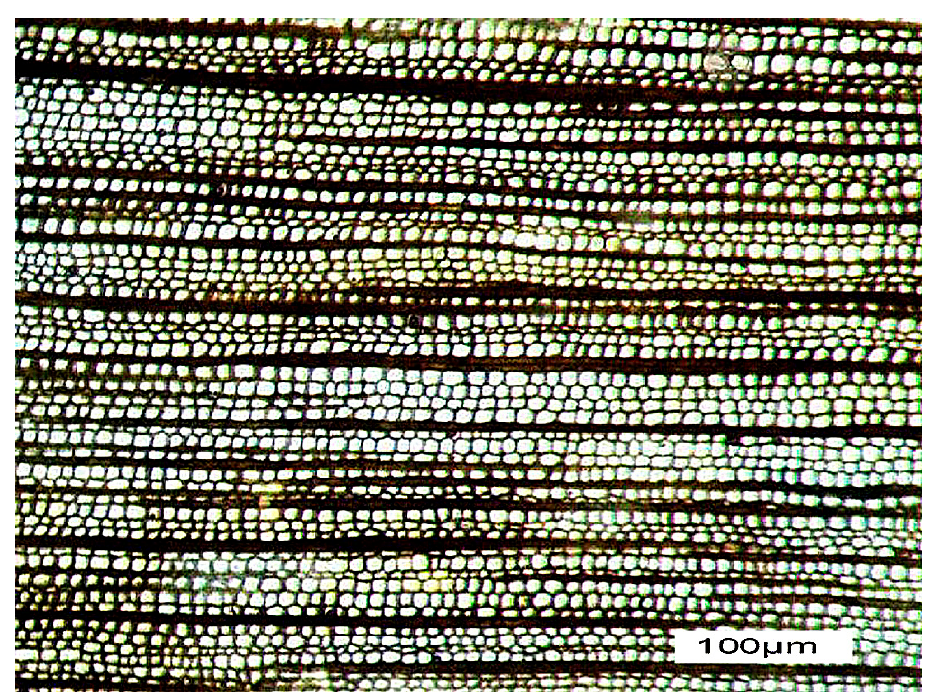
Figure 1. Callixylon whiteanum , petrographic thin section, transverse orientation. Devonian, Woodford Shale, OK, USA. This new thin section is similar to the specimen described in 1947 by Arnold [4], showing dark carbonaceous cell walls enclosing silica-filled cell lumina.